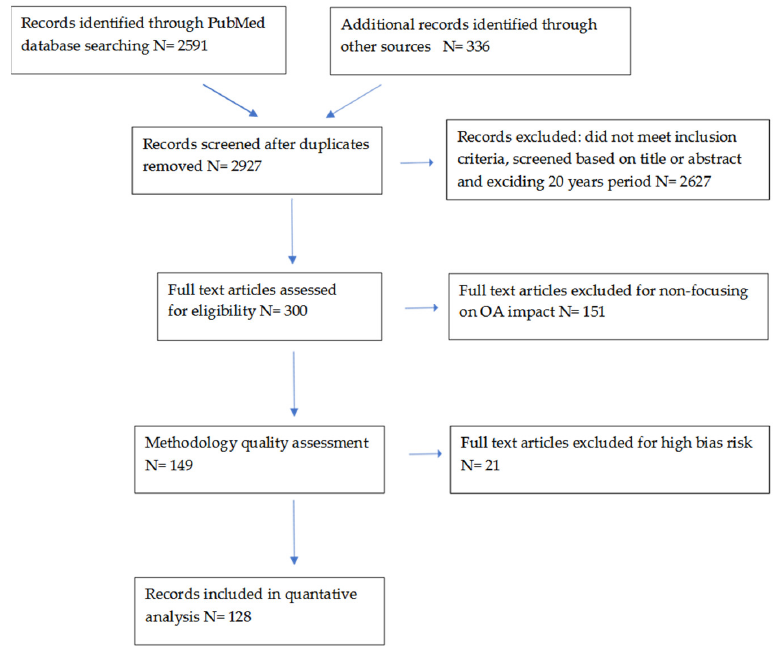
Figure 2. Flow diagram of literature search and selection process.